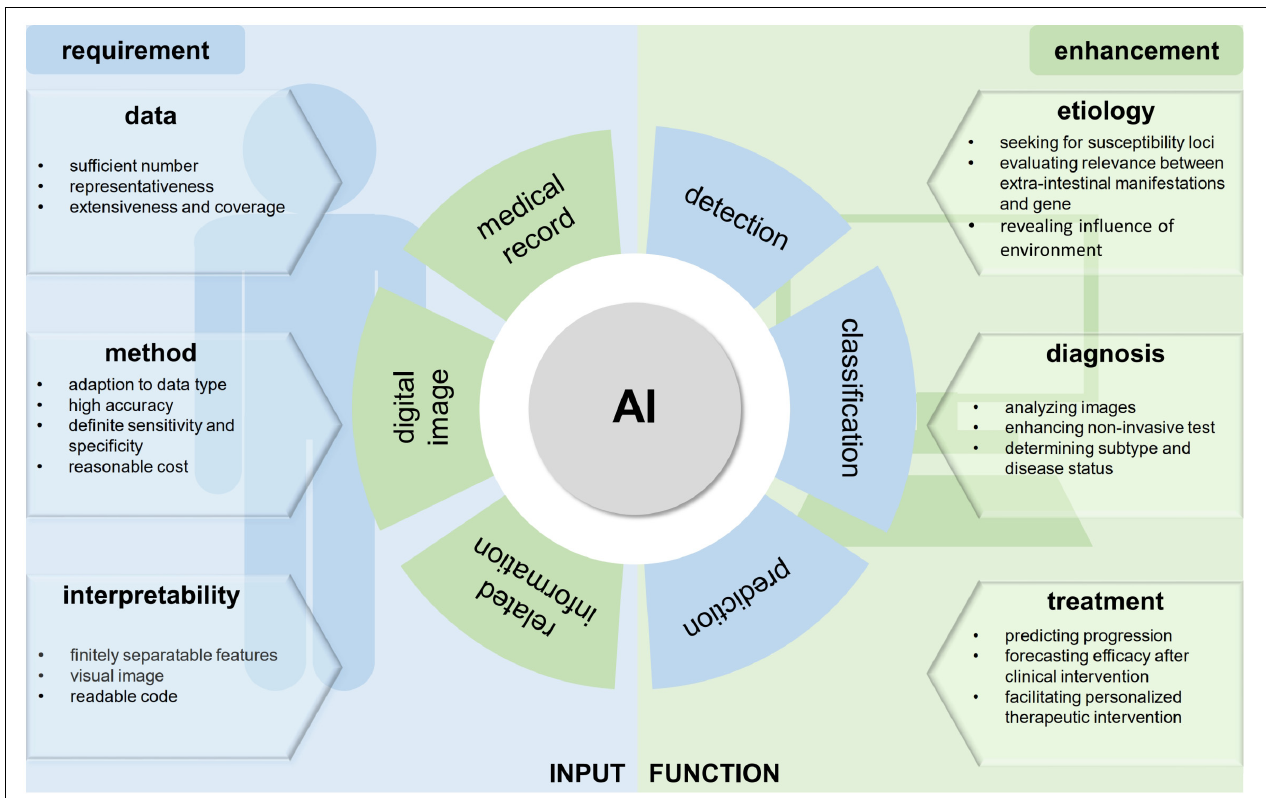
FIGURE 1 | The requirement of artificial intelligence (AI) application and the enhancement for inflammatory bowel disease (IBD) studies. The high-quality data at a certain volume are the basis of building and training the machine learning (ML) models. Making the appropriate match between the dataset and analysis methods is also an essential step, which can influence both accuracy and interpretability of results. The AI application in IBD study was summarized and sorted by the research purpose. In the field of IBD etiology, diagnosis, and treatment, AI methods played distinct